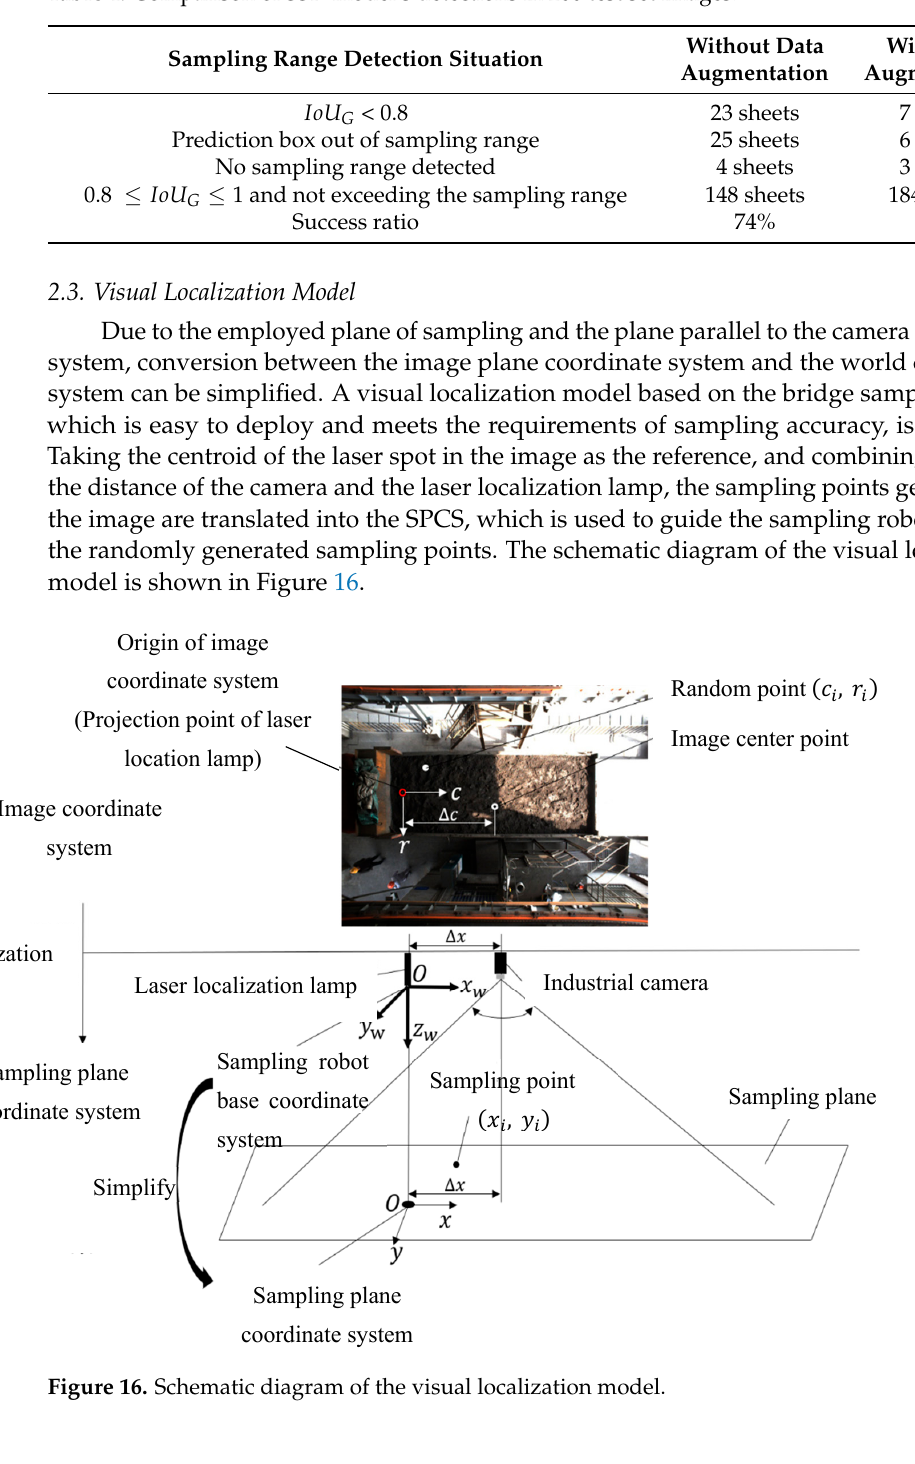
Table 4. Comparison of SSD model’s detections in 200 test set images.